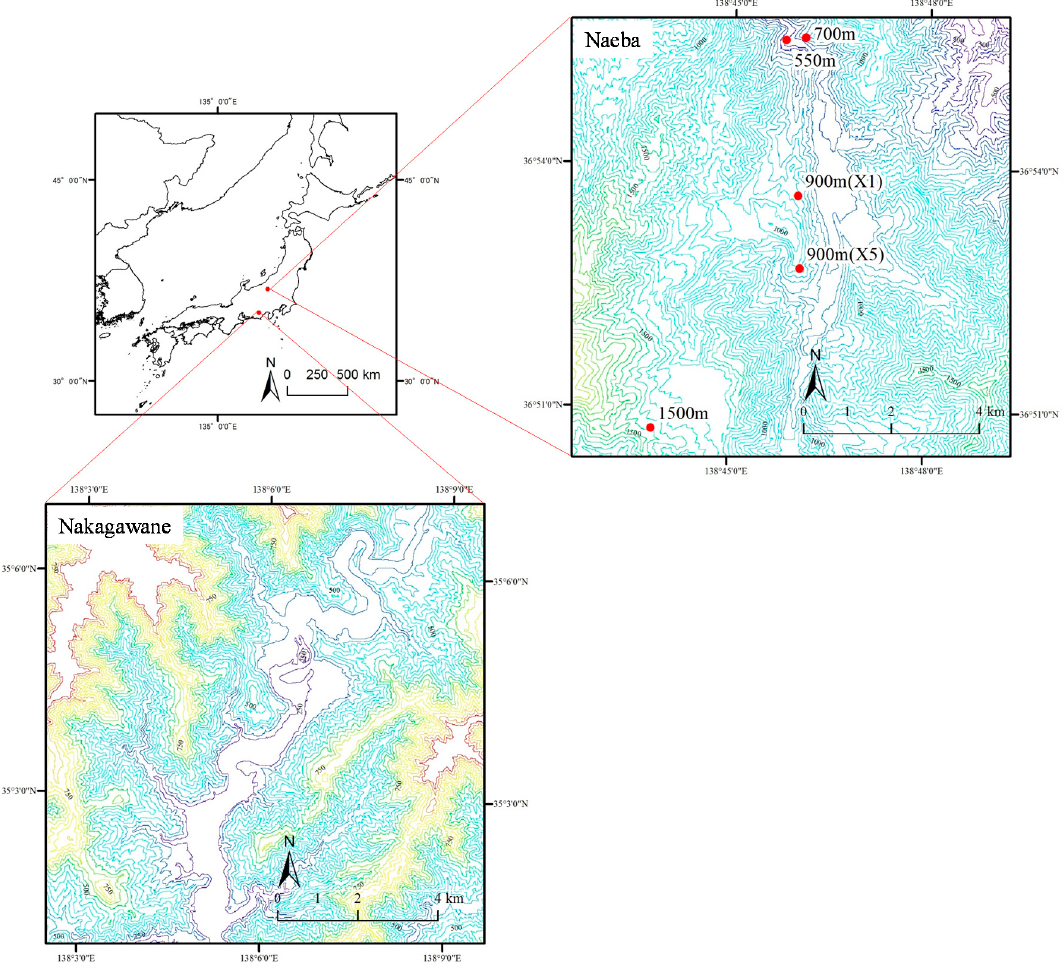
Figure 1. Locations of Mount Naeba and Nakagawane in Japan.